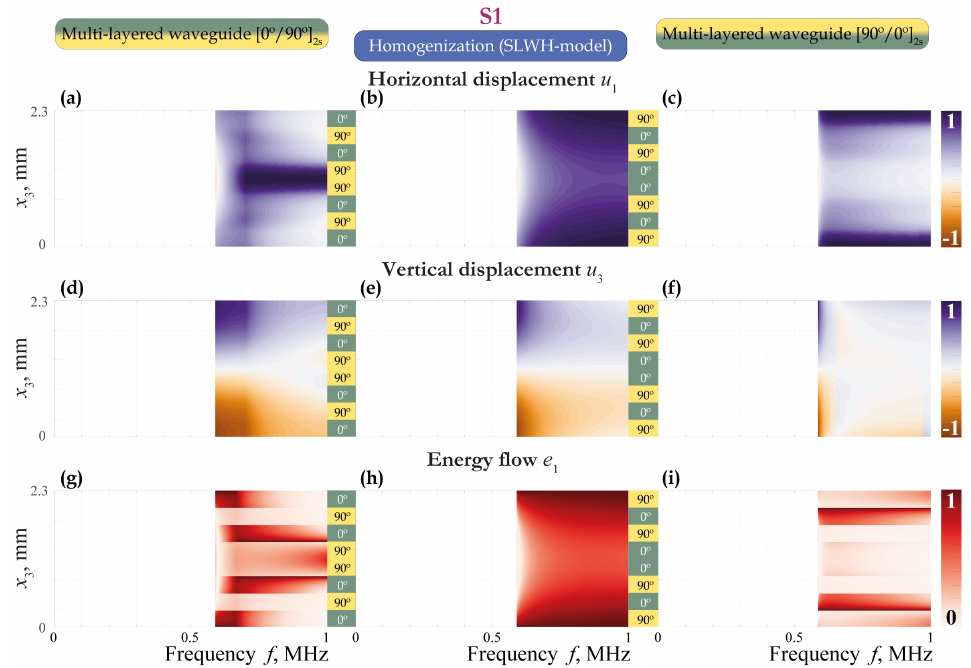
Figure 9. Eigenforms for the first fundamental guided wave S1 propagating in multi-layered waveg- uide [ 0 ◦ ,90 ◦ ] 2s ( a , d , g ), homogeneous waveguide according to the SLWH-model ( b , e , h ), and multi- layered waveguide [ 90 ◦ ,0 ◦ ] 2s ( c , f , i